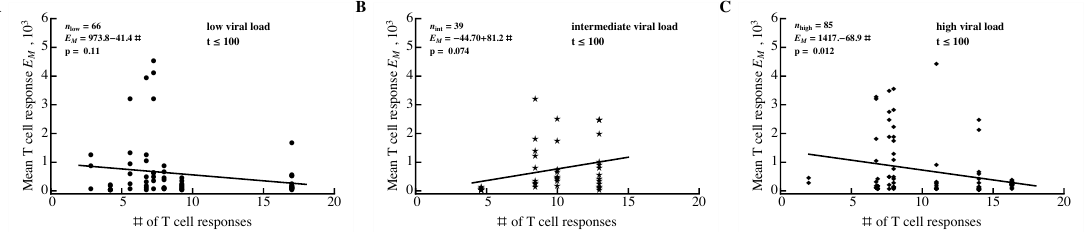
Figure 9. Average size of epitope-specific CD8 + T-cell response is unrelated to the number of HIV-specific T-cell responses. For every patient, we calculated the average number of HIV-specific CD8 + T-cell responses and the average density of epitope-specific T cells in a given observation period. To exclude the contribution of viral load to this relationship, we divided all 22 patients into three groups according to their mean viral load (low log viral load: 3.40–4.44 (disks) ( A ); intermediate 10 viral load: 4.60–5.03 (stars) ( B ); high viral load: 5.25–6.83 (diamonds) ( C )). Groups were estimated using the Manhattan Distance with the FindClusters function in Mathematica. Regression lines and corresponding p values are indicated on individual panels. Overall, results varied by time period and most correlations were not statistically significant (Figure